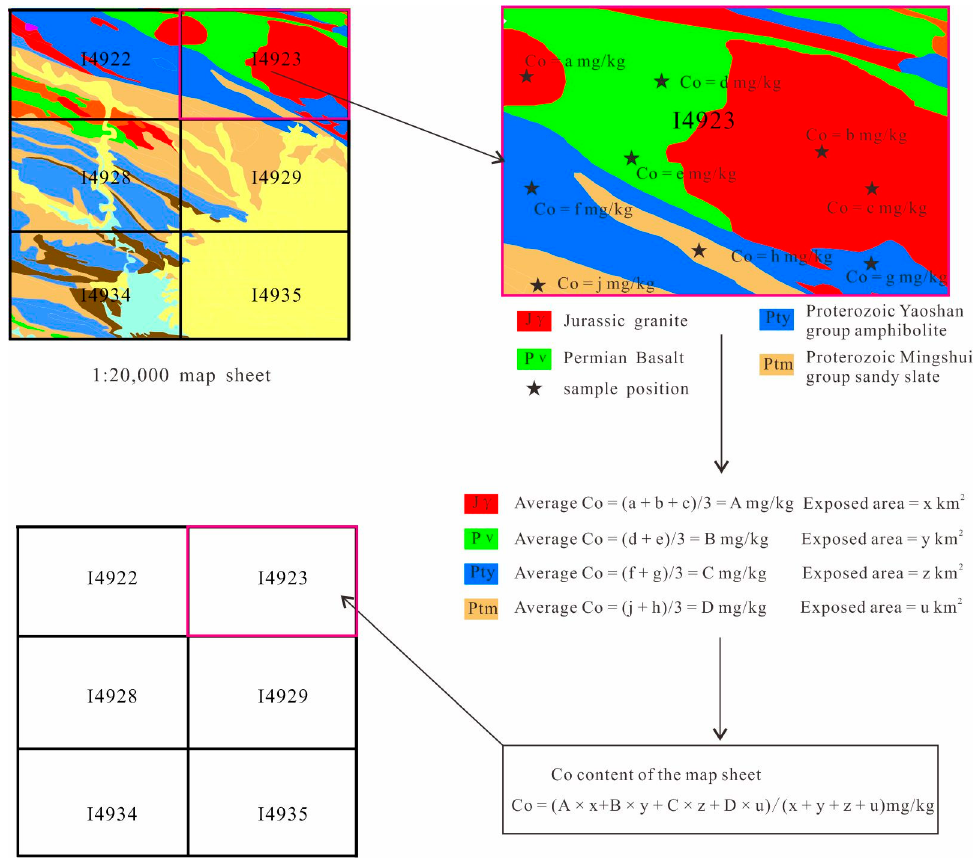
Figure 3. Schematic diagram of the process of assignment of cobalt content to 1:200,000 geological map grids.